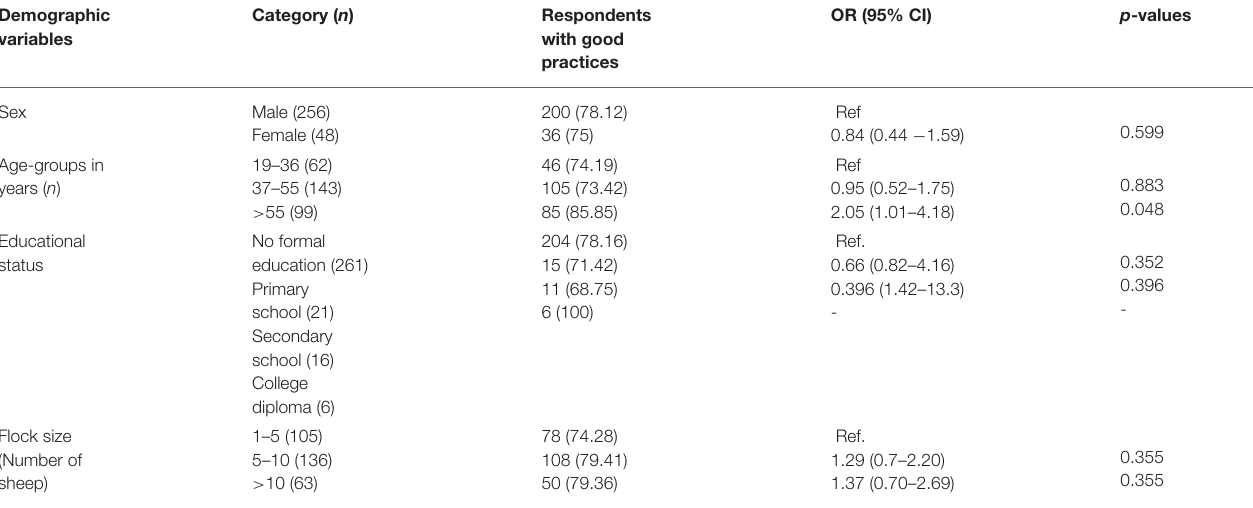
TABLE 10 | Association of demographic variables with practice of animal owners toward ovine pasteurellosis ( n =